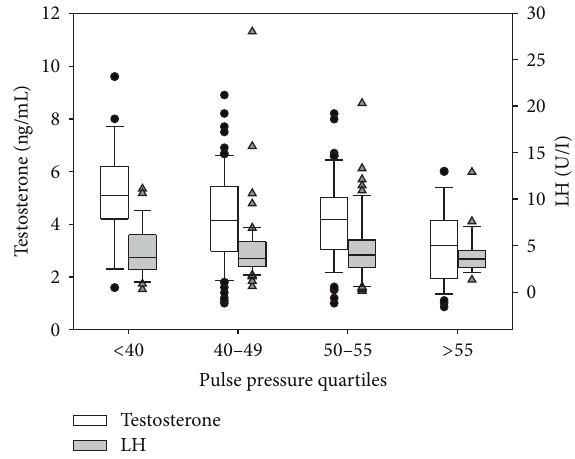
Figure 5: Distribution of testosterone and LH levels stratified according to quartiles of pulse pressure. Open boxes are total testosterone values (left vertical axis) and solid gray boxes are LH values (right vertical axis).